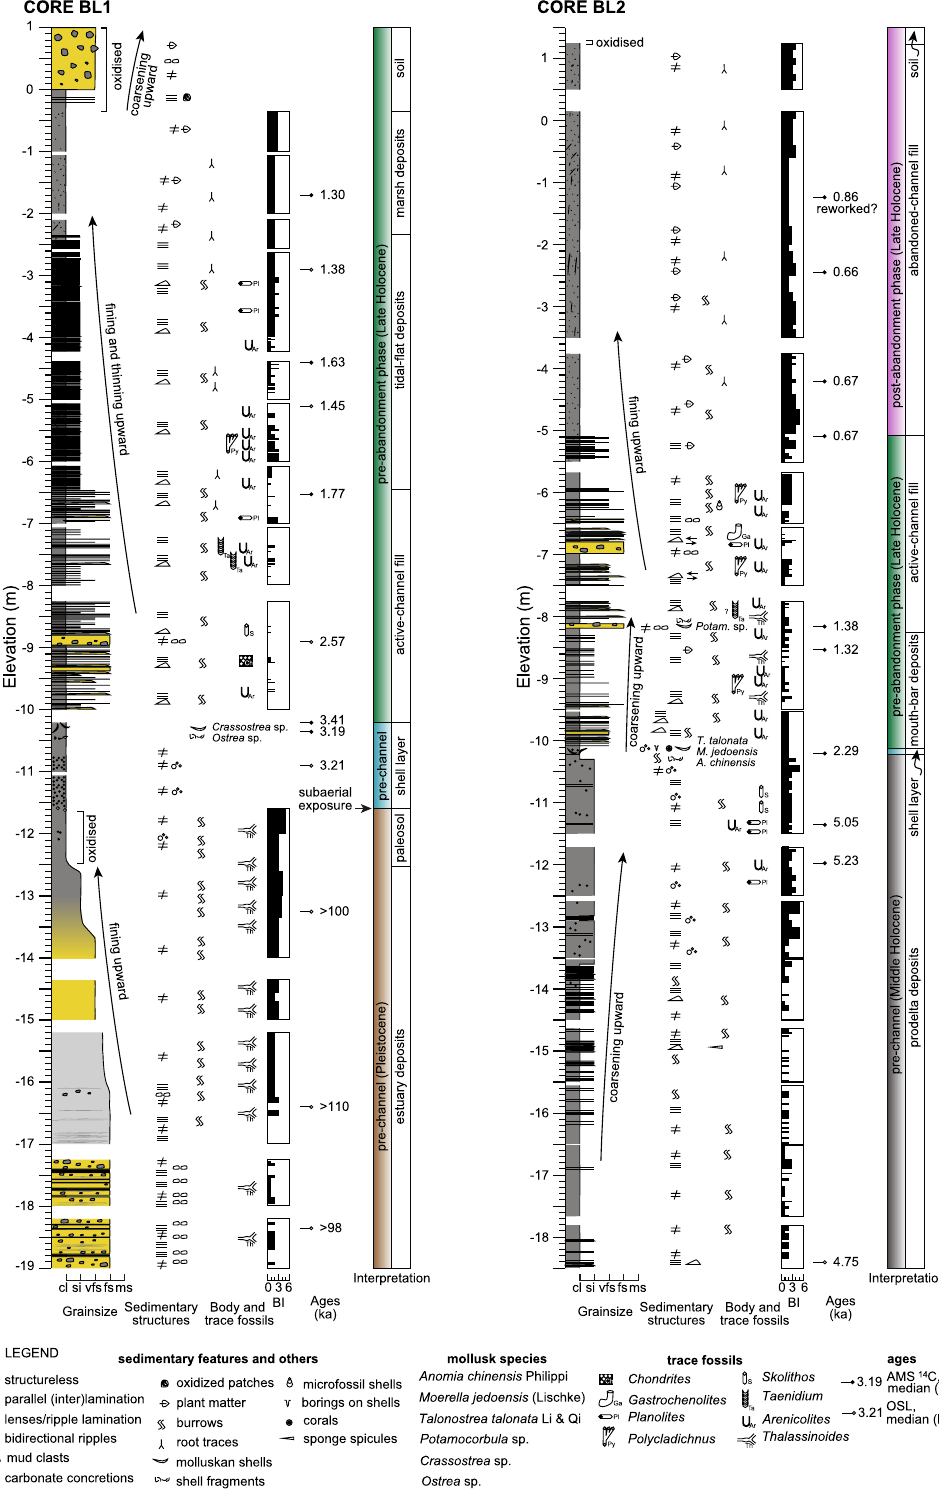
Figure 2. Sedimentological logs of the cores BL1 and BL2 with information about sedimentary features, trace and body fossils, ages and interpretations. Grain-size scale: cl = clay; si = silt; vfs = very-fine sand; fs = fine sand; ms = medium